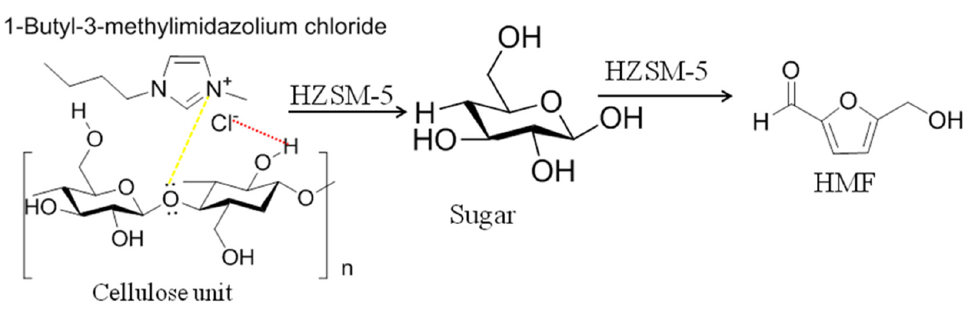
Figure 6. Mechanism of cellulose hydrolysis with H-ZSM-5 catalyst in the presence of [BMIM] Cl ionic liquid .